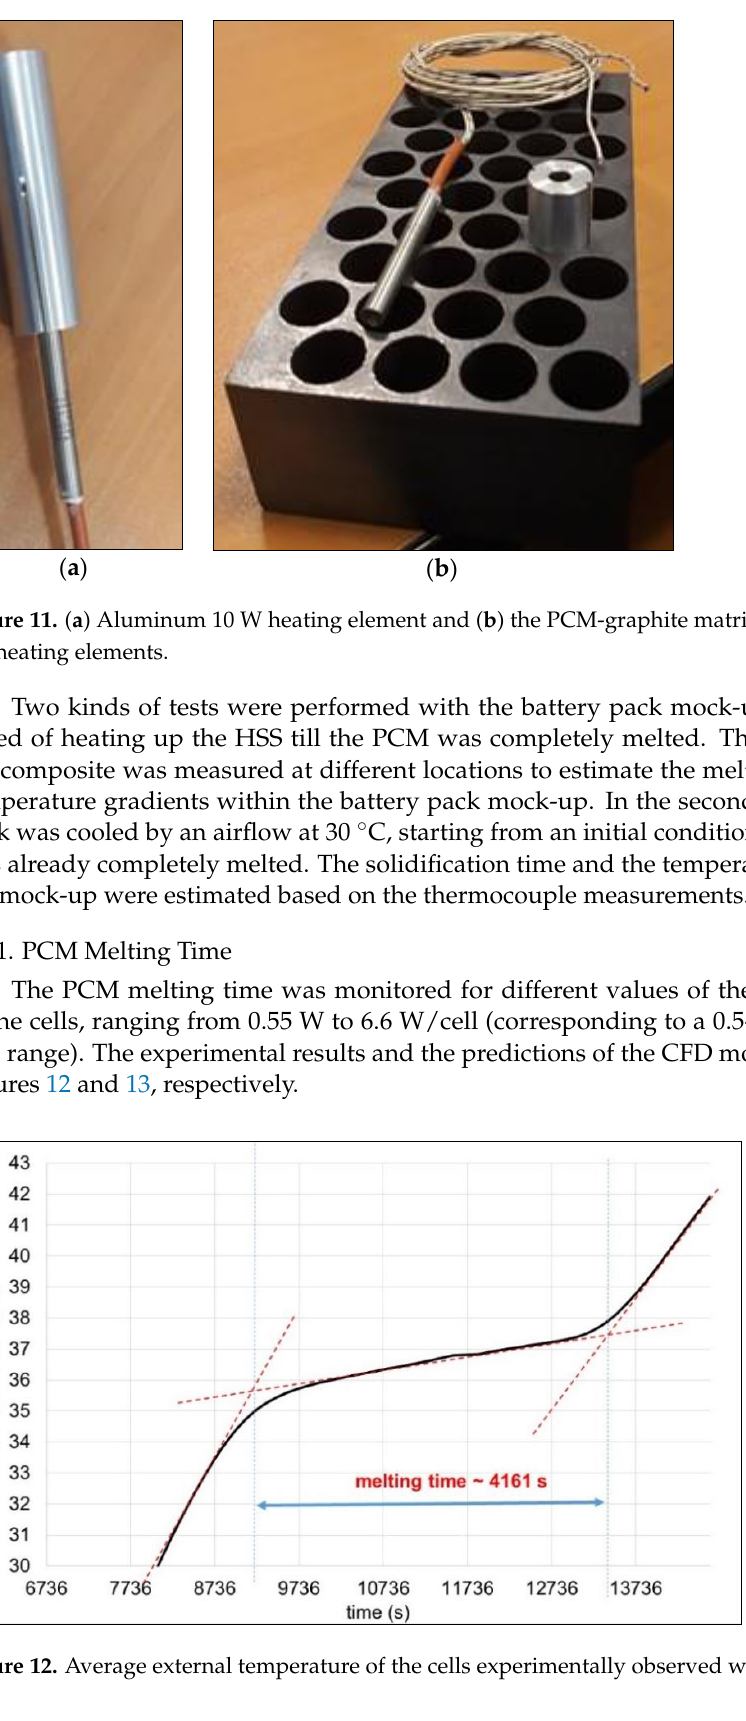
Figure 13. Average external temperature of the cells estimated by CFD calculations with P = 0.55 W/cell.